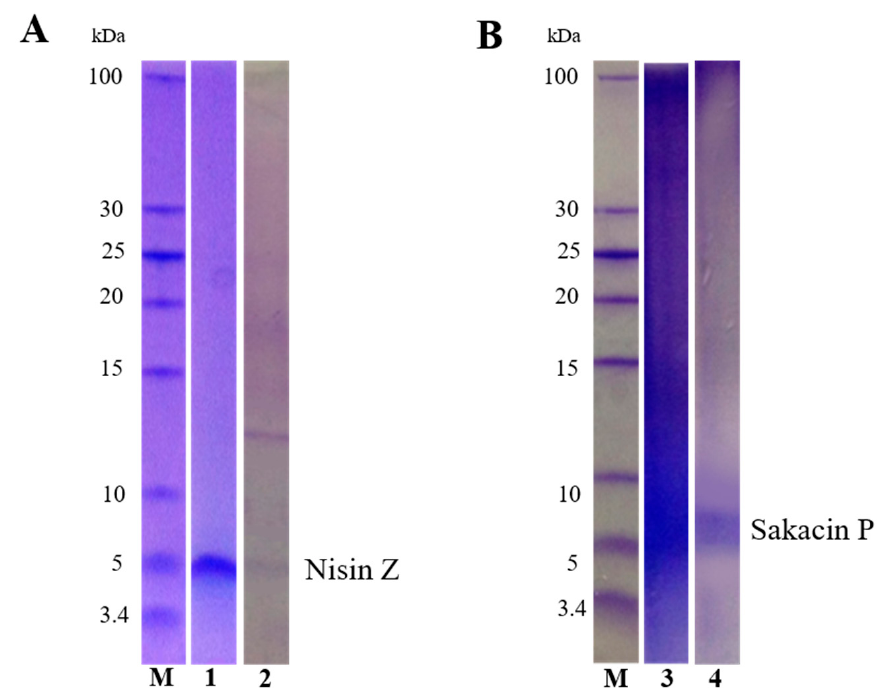
Figure 2. Tricine-SDS-PAGE Coomassie stained gel of purified Nisin Z and Sakacin P. Panel ( A ): antimicrobial fractions of L. lactis 41FLL3 grown in M17 enriched with fructose (2% w/v ) (1) and with glucose (2% w/v ) (2). Panel ( B ): antimicrobial fraction of L. sakei I151 after purification with cation exchange column (3) and hydrophobic interaction column (4). M: marker.